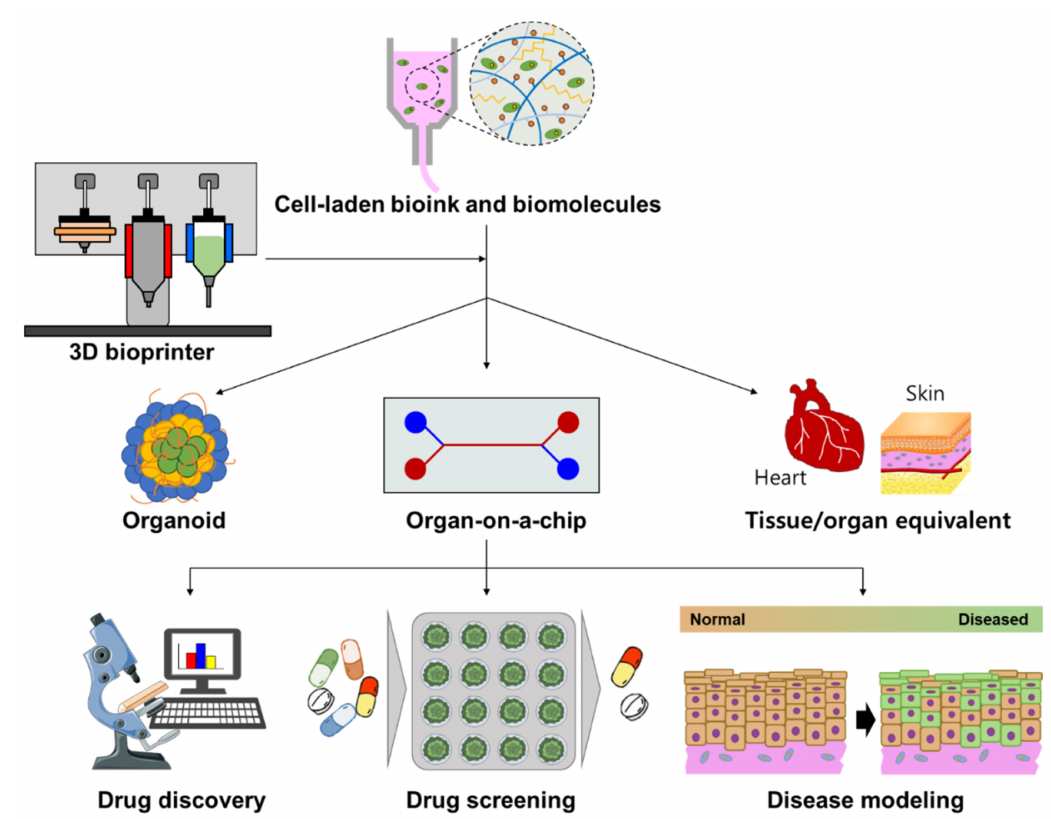
Figure 3. Schematic illustration representing 3D bioprinting, enabling the establishment of 3D cell culture devices, including organoid, organ-on-a-chip, and tissue/organ equivalent, that can advance pharmaceutical applications of drug discovery, drug screening, and disease modeling. This figure was prepared using a template on the Sevier medical art website (http://www.sevier.fr/sevier-medical-art, accessed on 12 July